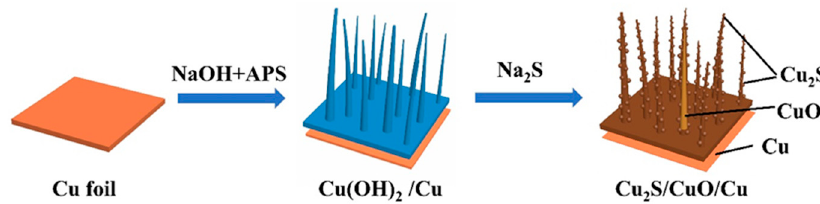
Figure 1. Schematic illustration of the fabrication process of Cu 2 S/CuO@Cu.